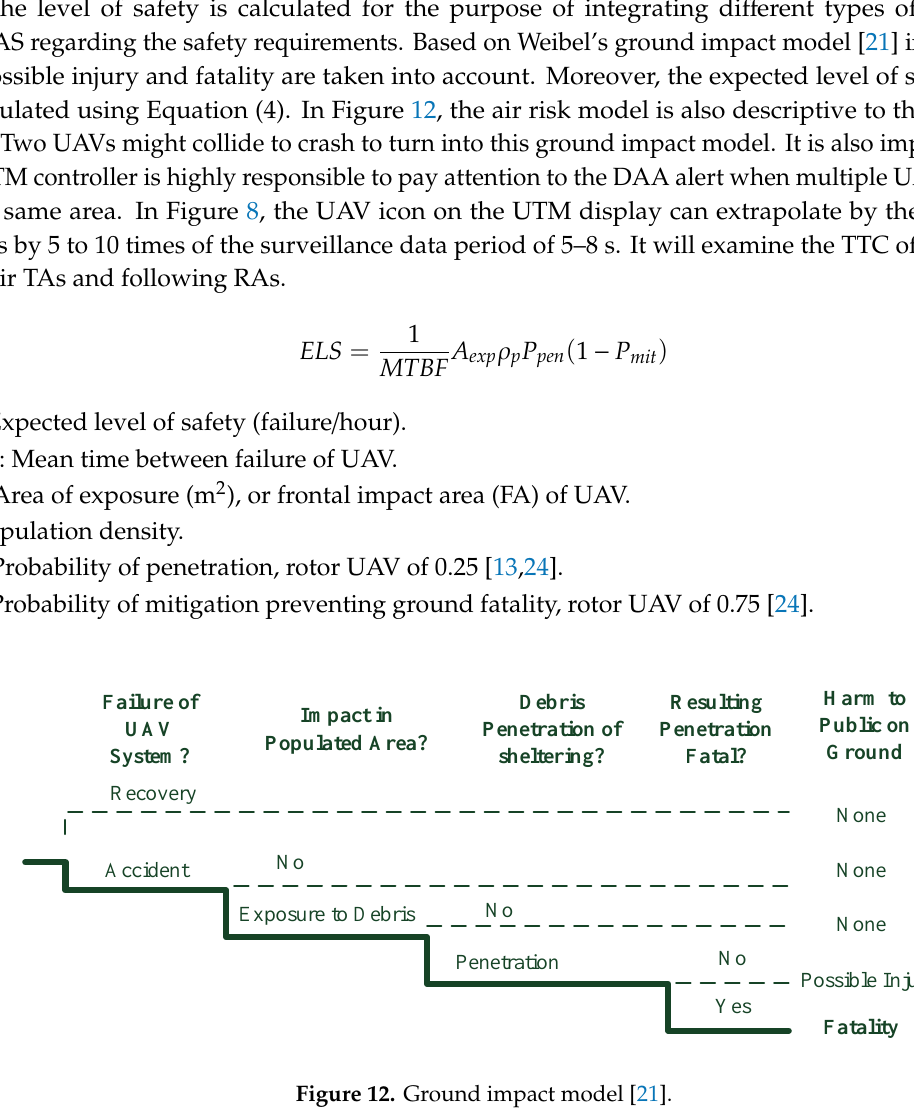
Table 1. Comparison of risk level for this study and using FAA data [1].